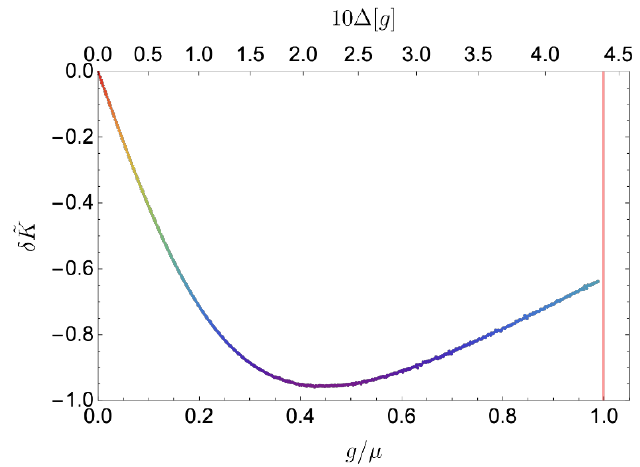
Figure 6 . (cid:14) ~ K (see eq. (3.43)) as a function of g (the o(cid:11)-diagonal component of B ). In this example, a 1 =(cid:22) = 4 ; a 2 =(cid:22) = 2 ; b 1 =(cid:22) = 2 and b 2 =(cid:22) = 3 . The red vertical line indicates the upper 2 bound g=(cid:22) = 1 for the parameter g , which is constrained by the positivity of the matrix A (cid:0) B . Along the top axis, (cid:1) is a measure which quanti(cid:12)es the deviation of A and B from being commuting | see eq.